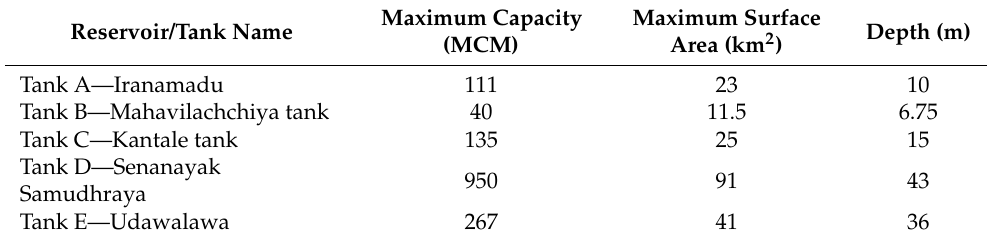
Table 1. Maximum reservoir capacity, surface water area, and maximum depth for selected five